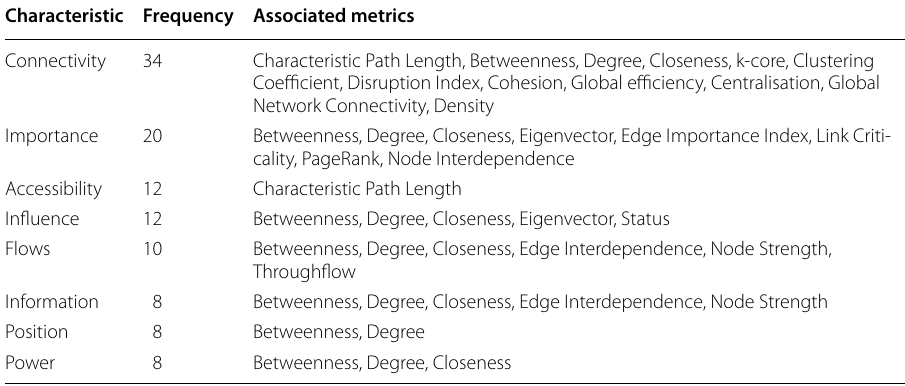
Network Connectivity, Density